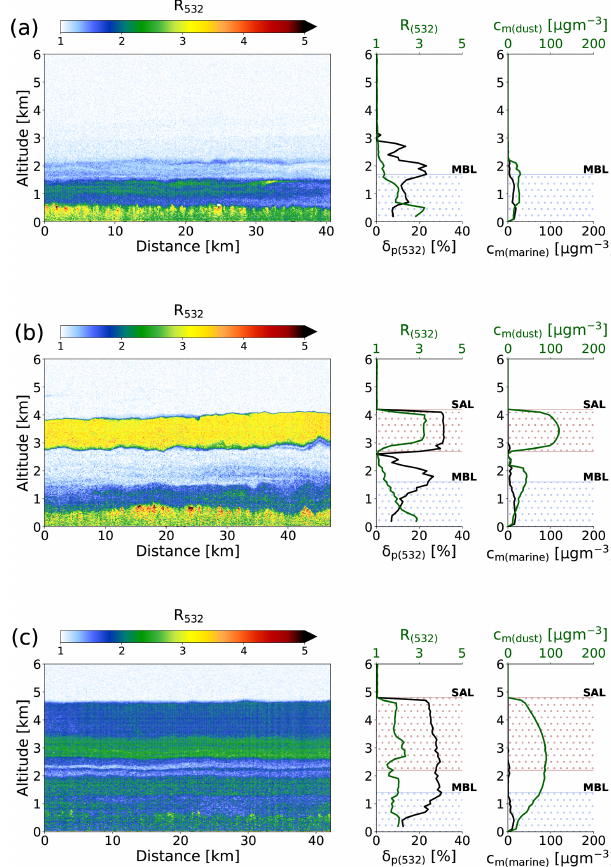
Figure 2. Left: cross sections of WALES backscatter ratio R ( 532 ) ; middle: averaged profiles of particle linear depolarization ratios δ p( 532 ) (black) and backscatter ratio R ( 532 ) (green); and right: de- rived aerosol mass concentrations ( c m(dust) (green) and c m(marine) (black)) for cases (a) and (b) on 19 August 2016 and case (c) on 12 August